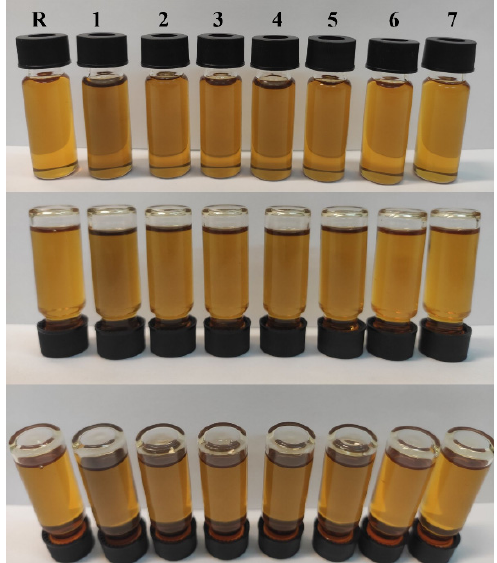
Figure 1. Photographs of the reference 5W-40 synthetic oil (R) and the prepared oil samples incorporating rGO at different concentrations (R—0 wt %, 1—0.2 wt %, 2—0.1 wt %, 3—0.08 wt %, 4—0.06 wt %, 5—0.04 wt %, 6—0.02 wt % and 7—0.01 wt %), photographed from different angles.